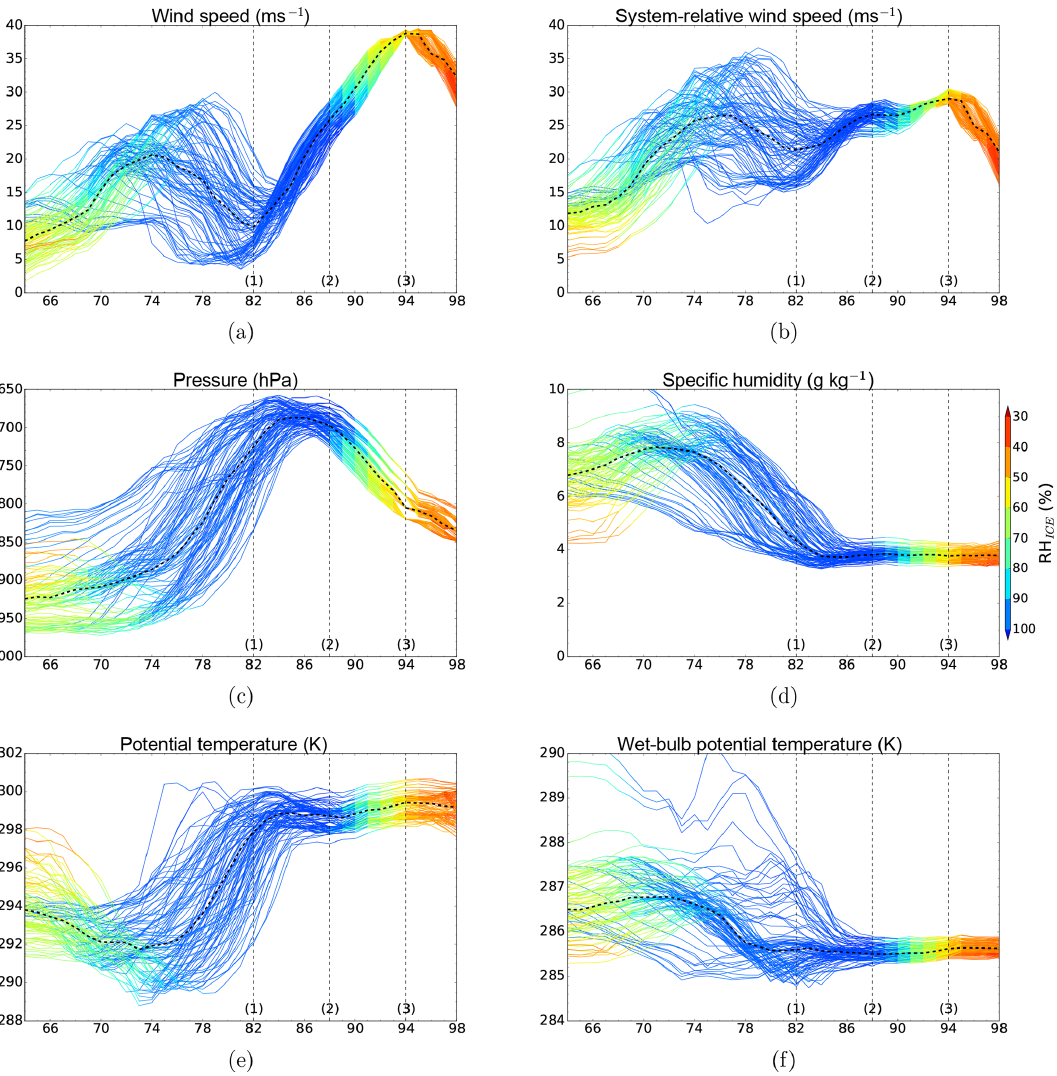
Figure 4. Time series (hours since start of the run) of (a) wind speed, (b) system-relative wind speed, (c) pressure, (d) specific humidity, (e) potential temperature and (f) θ w along SJ trajectories. Colours indicate relative humidity with respect to ice along trajectories, and the dashed line indicates the median of